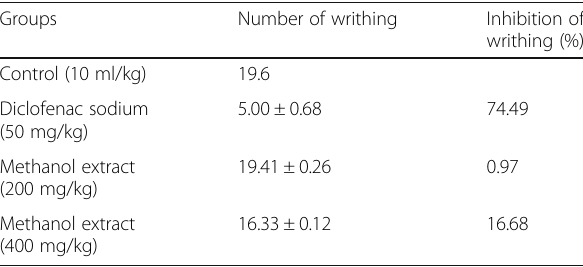
Table 4 Effect of L. speciosa flower extract on acetic acid-induced writhing in mice Groups